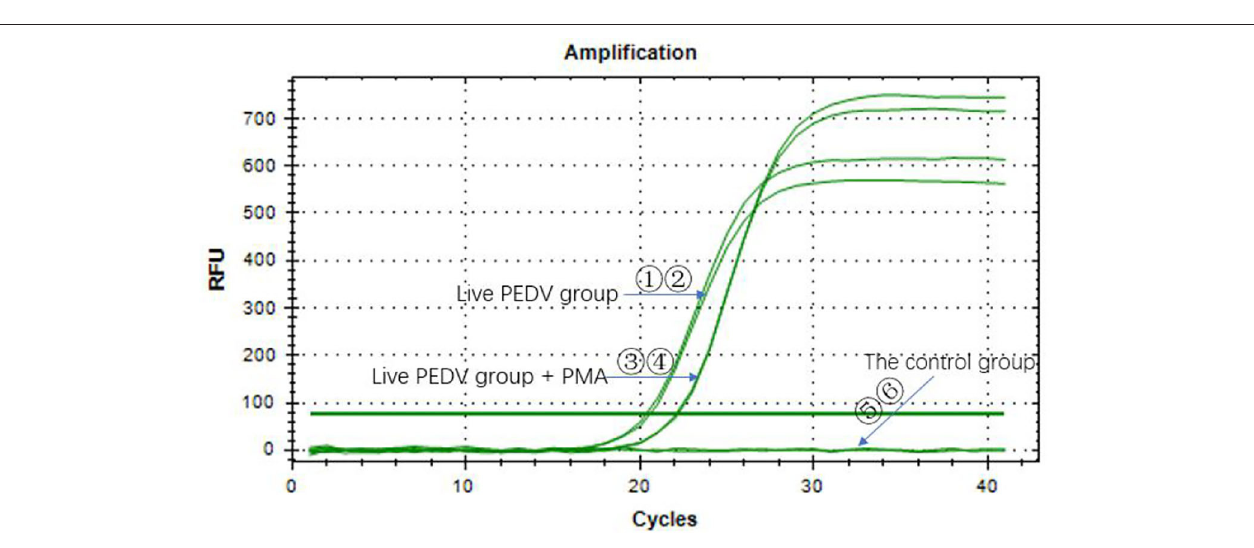
FIGURE 2 | Effect of PMA on the qPCR detection of porcine pseudorabies virus.